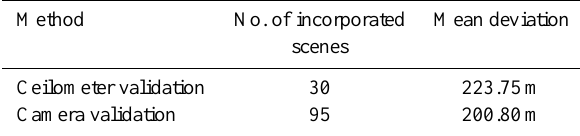
Table 7. Validation results for the DOGMA cloud base